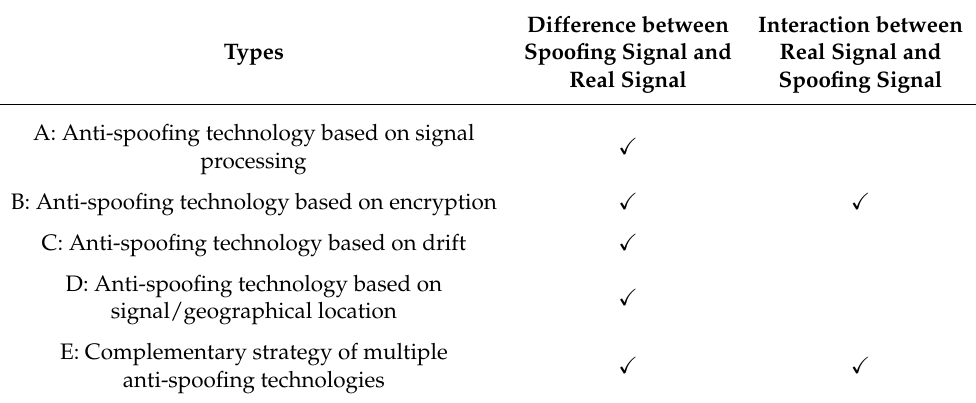
Table 3. Defense strategies of anti-spoofing technology under